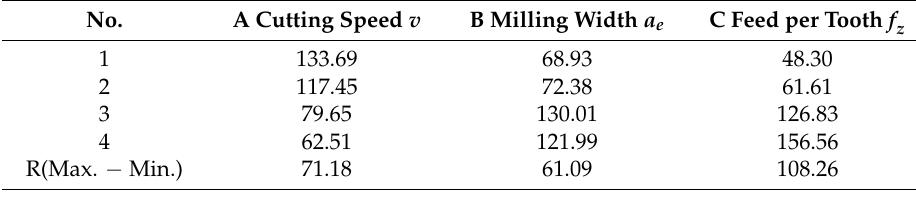
Table 7. Range table of F y (N).